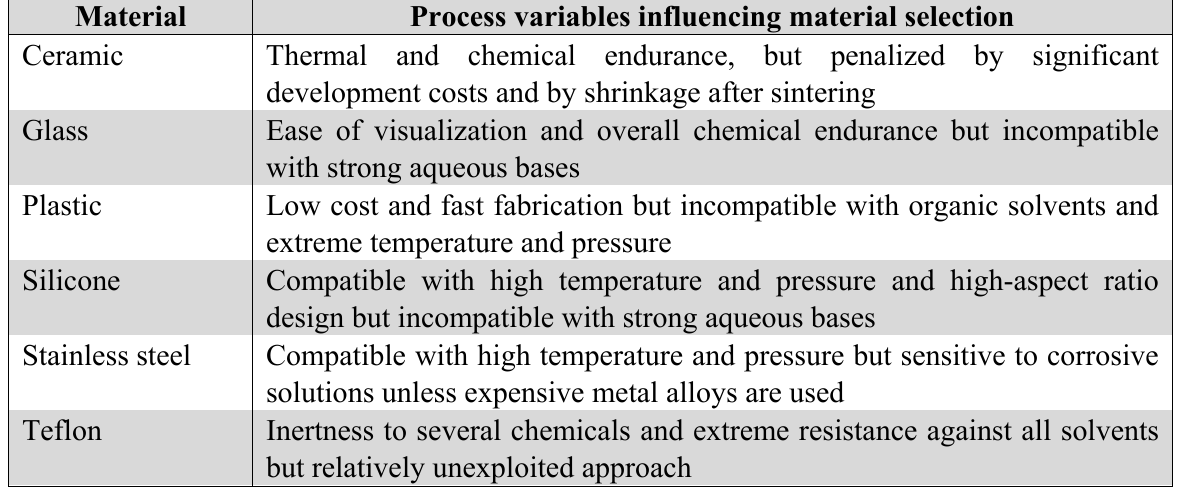
Table 1. A brief overview of how process parameters may condition the selection of materials for the fabrication of microfluidic devices (adapted from